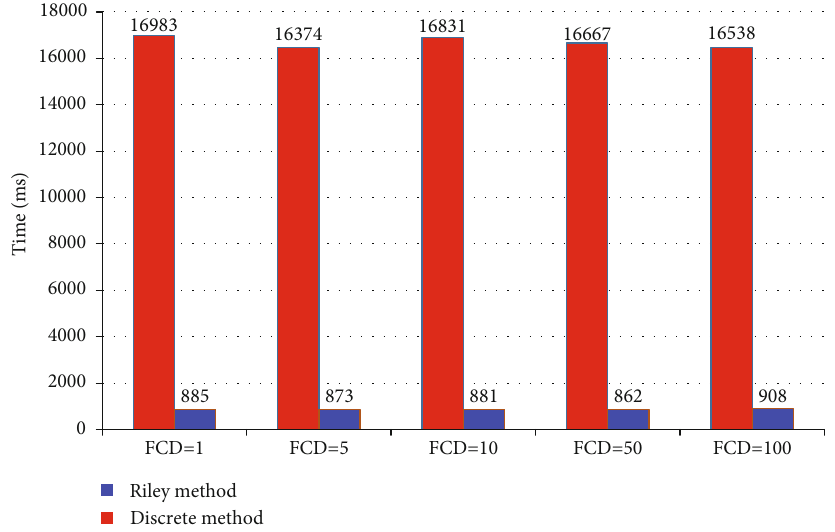
Figure 6: Comparison of calculation time between the Riley method and discrete